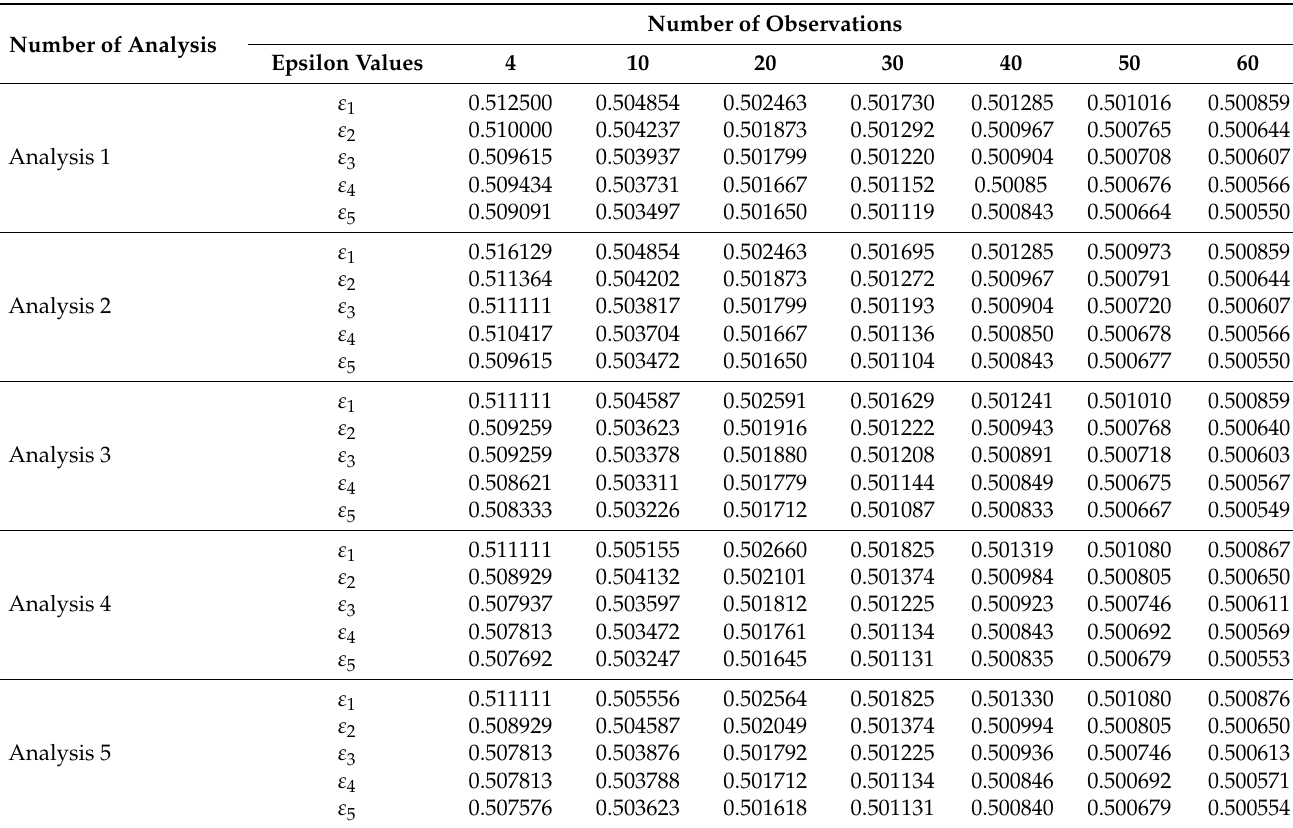
Table 3. ε similarity coefficient values depending on the number of observations included in the model at x i (1) equal to 7.